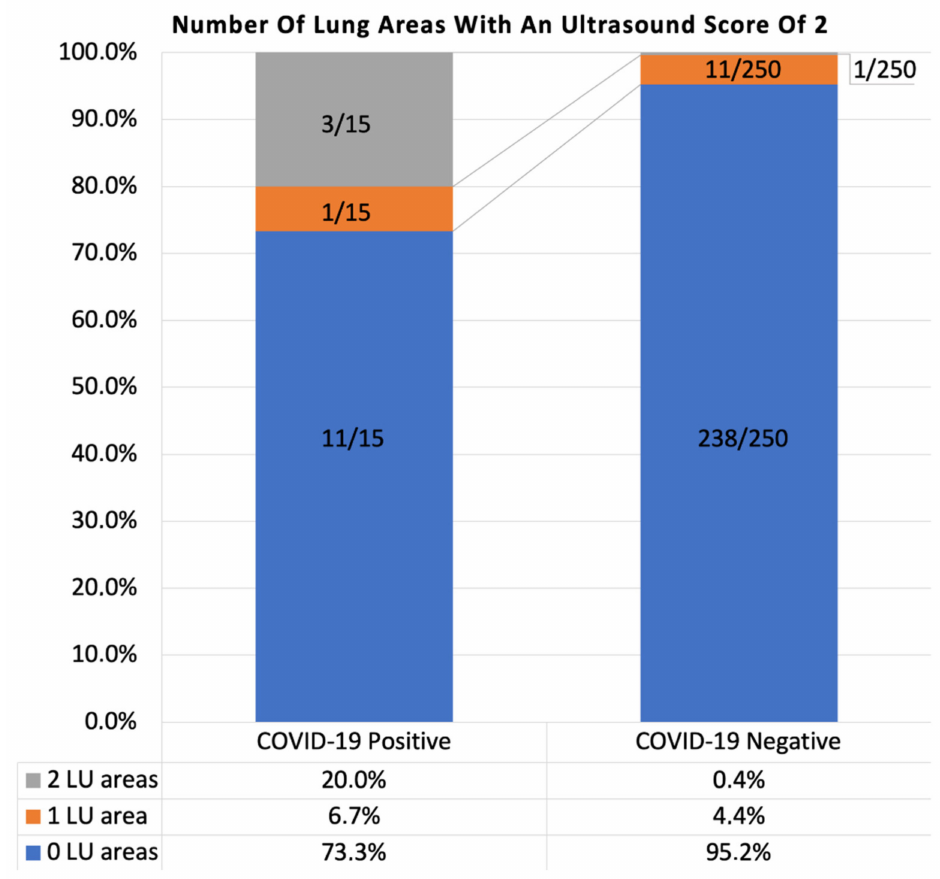
Figure 5. Number of lung areas interested by lung alteration 2 (LUA 2) in COVID-19 positive and negative group. LU = lung ultrasound.